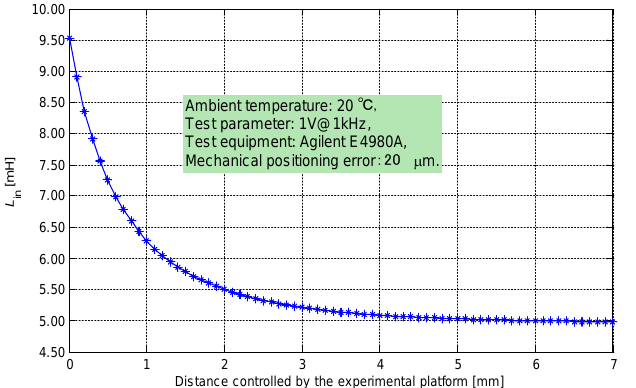
Figure 6. Calibration of distance vs. L .